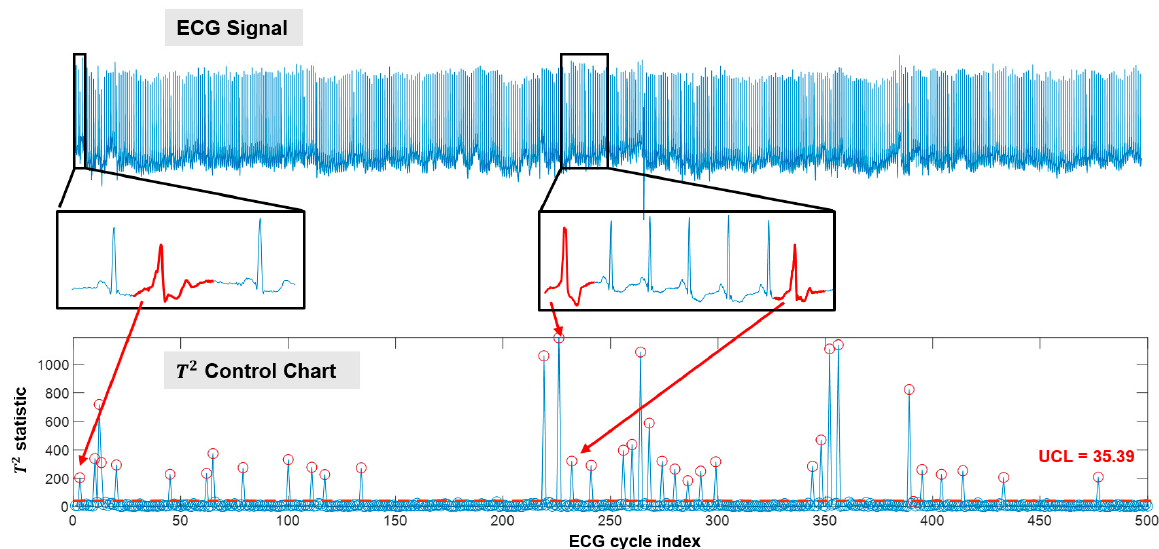
Figure 6. Cycle-based monitoring and anomaly detection for patient s20041 in the PhysioNet long-term ST dataset (only 500 cycles are demonstrated).